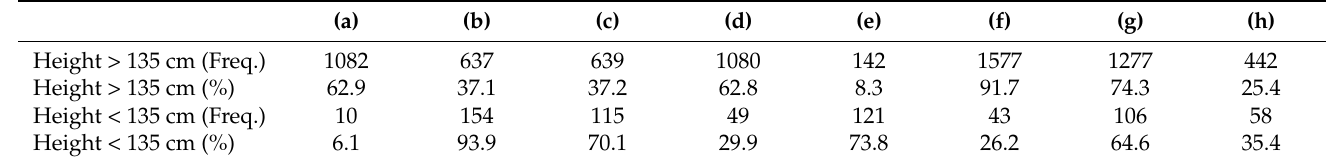
Table 10. Habits when traveling by car. A comparative study based on the height of the student. Percentages refer to the number of students with a height greater or less than 135 cm (1719 and 164, respectively). (a) Passenger seat; (b) no passenger seat; (c) back seat; (d) no back seat; (e) use